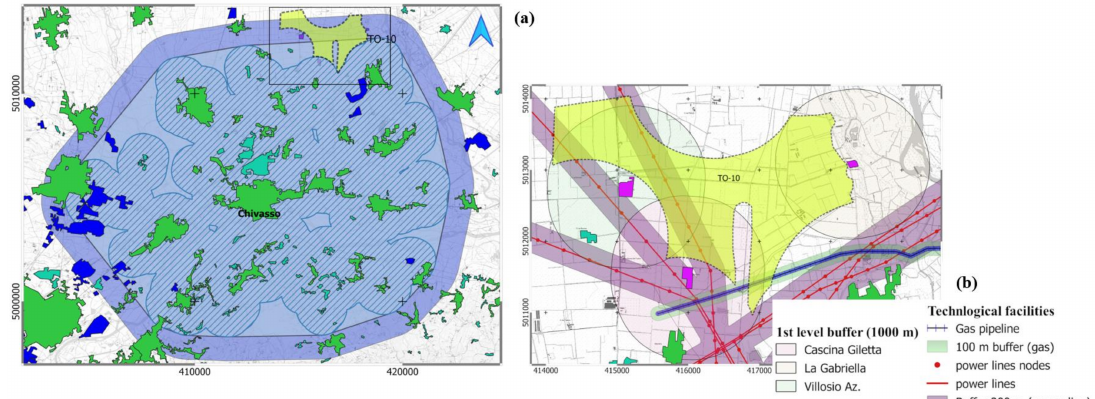
Figure 12. ( a ) 2nd level buffer (“local urbanism”) of the Chivasso municipality. The external blue polygon is the buffer area around the convex-hull defining the local urbanism of Chivasso mapped according to the procedure reported in [37]. ( b ) 1st level buffers (circular, 1 km radius) around the three settlements (Cascina Giletta, Cascina Gabriella and the Villosio bio-gas production plant) that Sogin didn’t consider during its evaluation, since not mapped in the ISTAT LOC2011 layer. In ( b ) power and gas lines layouts are also reported together with correspondent safety buffers (200 m for power lines and 100 m for gas lines) as required by Italian